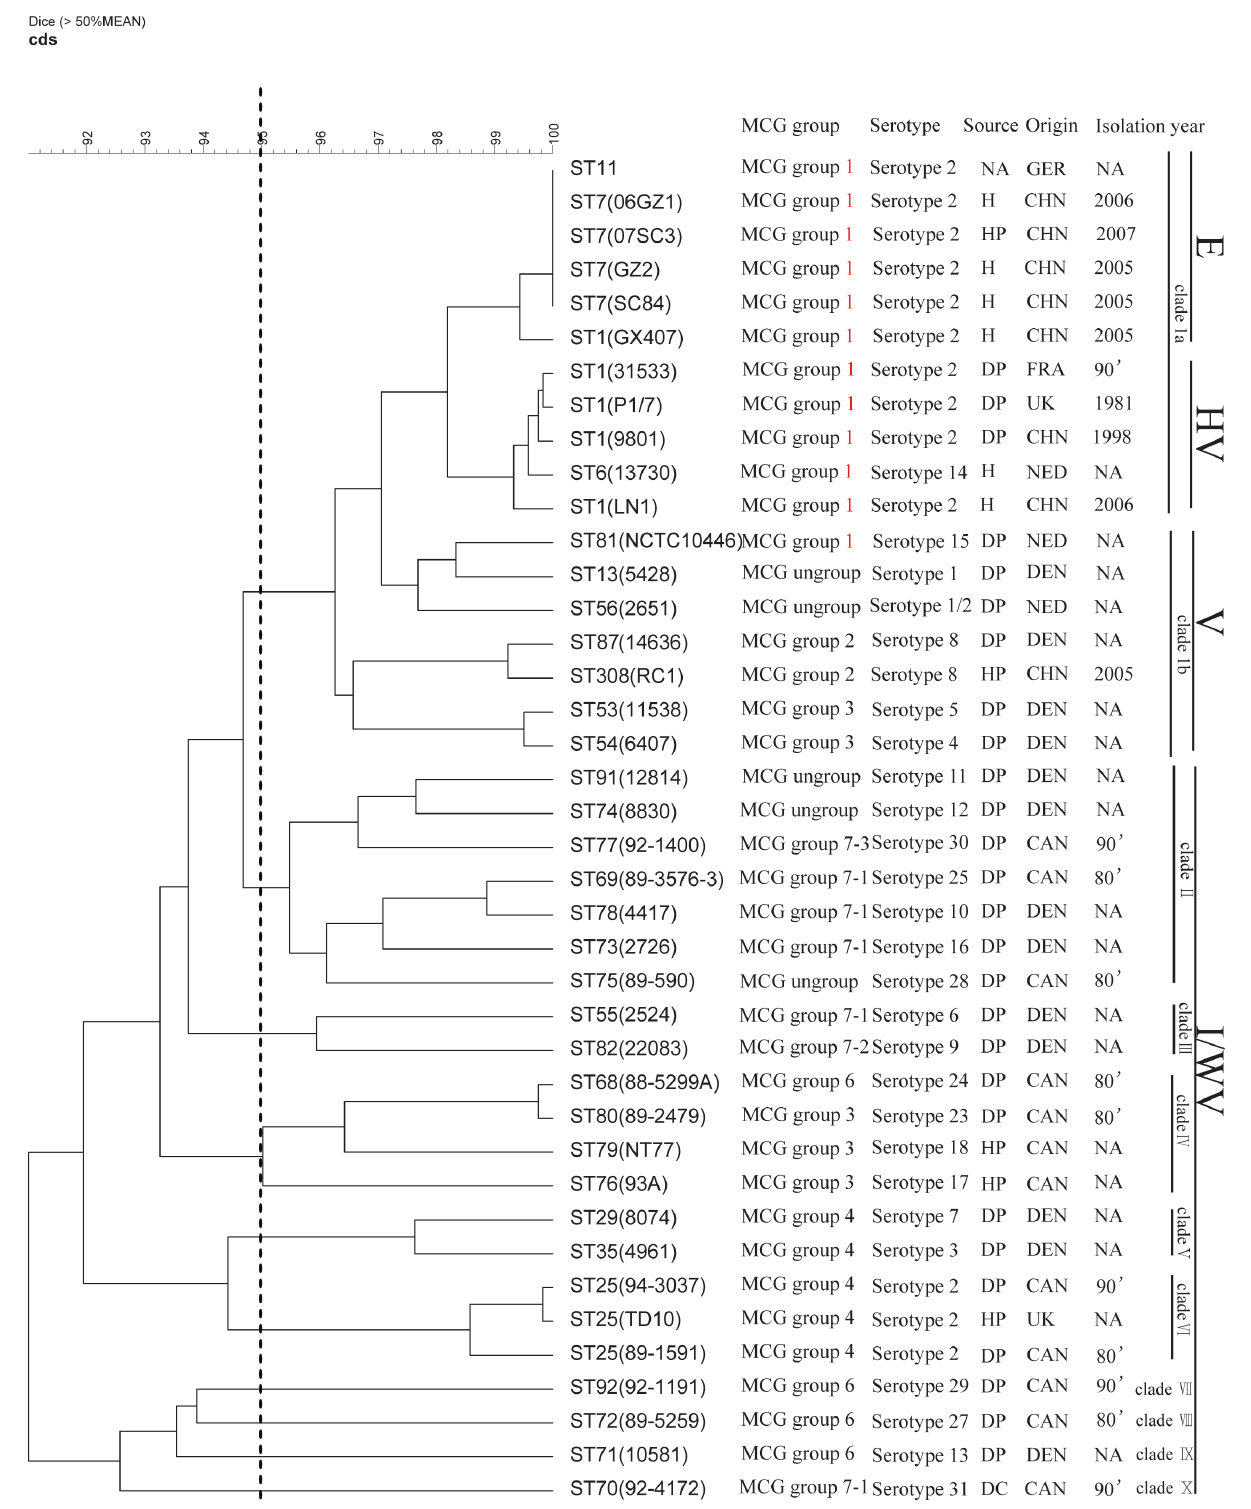
Figure 1. Phylogenetic relationship (UPGMA tree) of all 40 test strains and reference strain 89-1591 following DNA-DNA microarray hybridization. Absence and presence for each gene of each strain were translated to 0 and 1, respectively. The UPGMA tree shown was calculated from difference matrices with BioNumerics. E/HV: epidemic/highly virulent group, V: virulent group, I/WV: intermediately or weakly virulent group. CHN, China; NED, Netherlands; GER, Germany; CAN, Canada; FRA, France; DEN, Denmark, UK: united kingdom. DP, diseased pig; DC, diseased calf; HP, healthy pig; H, patient. NA, not applicable.